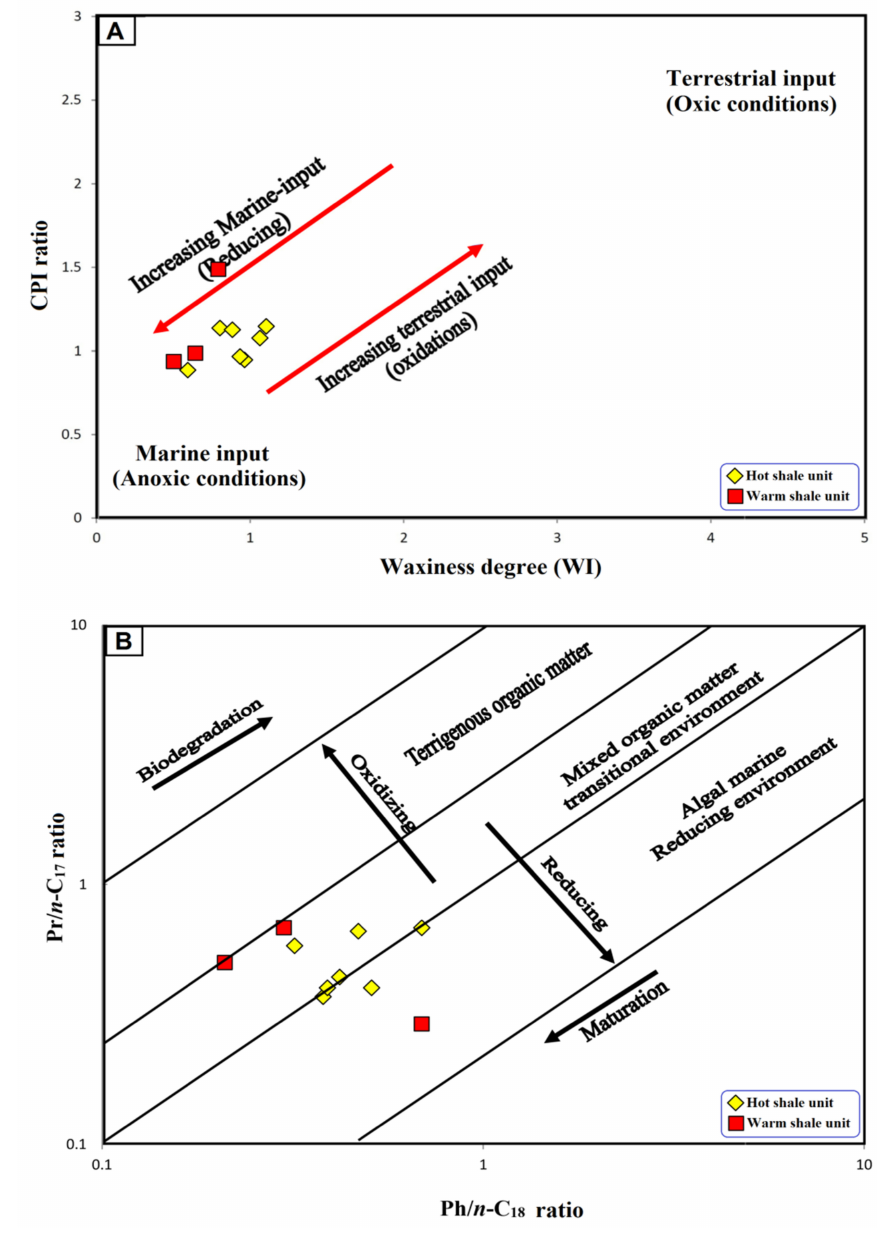
Figure 10. Geochemical biomarker results of the analyzed shales of the Qusaiba units showing ( A ) CPI versus waxiness degree and ( B ) pristane/ n -C17 versus phytane/ n -C18 (from Shanmugam, 1985), indicating that these sediments contain mixed organic matter and were deposited under suboxic to anoxic environmental